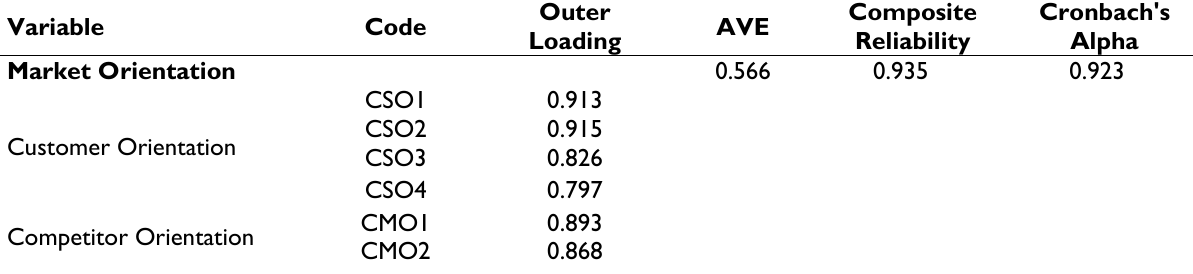
Table 2. Outer Model Test